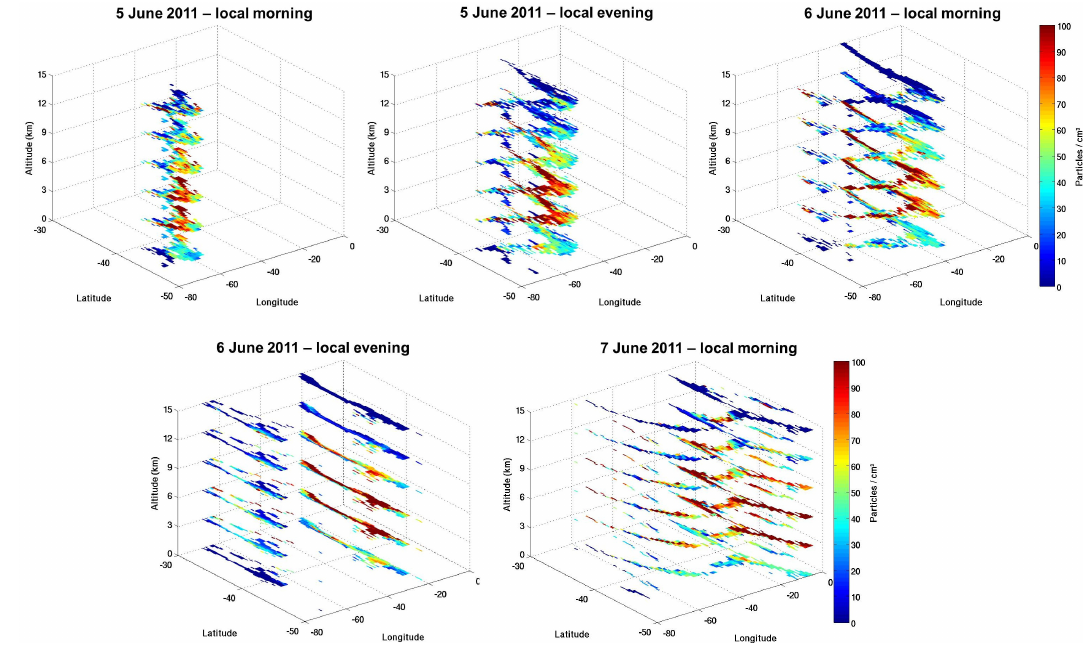
Figure 13. 3D view of the ash plume from 5 to 7 June